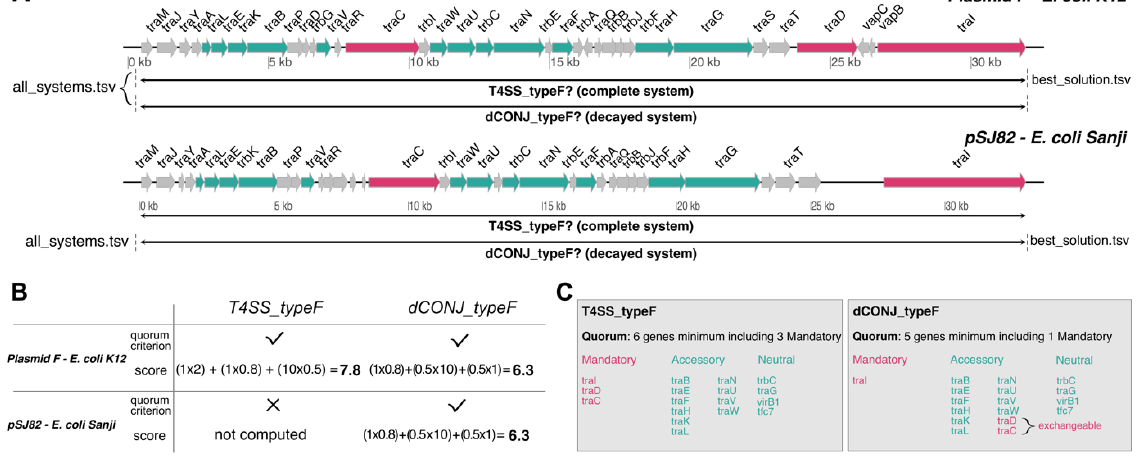
Figure 7 - Application of MacSyFinder v2 to distinguish complete and incomplete conjugative systems on bacterial plasmids with CONJscan v2.0.1. A. Representation of a complete conjugative system (top) and a decayed conjugative system (bottom). Arrows represent the predicted genes of the plasmids and their orientation. Mandatory and accessory genes of the systems are represented in fuchsia and cyan respectively. B. Description of the score for the complete MPF F (T4SS_TypeF) model and “decayed” MPF F model (dCONJ_typeF) when computed by the scoring scheme of MacSyFinder v2 (detailed in Fig. 2A). CONJScan plasmids’ models were used all at once with the “all” option. C. Difference between the complete and decayed models for the MPF F . Both models list the same genes, but the required quorum of mandatory genes and total genes required are different. The model designed to detect complete systems (T4SS_typeF) requires 3 mandatory genes and 6 genes minimum, while the “decayed” model (dCONJ_typeF) was designed to require only 1 mandatory gene and the other mandatory genes were set as “accessory” and exchangeable between each other. Thus, we ensure that if the quorum is reached for a complete system, the score of the “complete” model is always higher than the score of the “decayed”